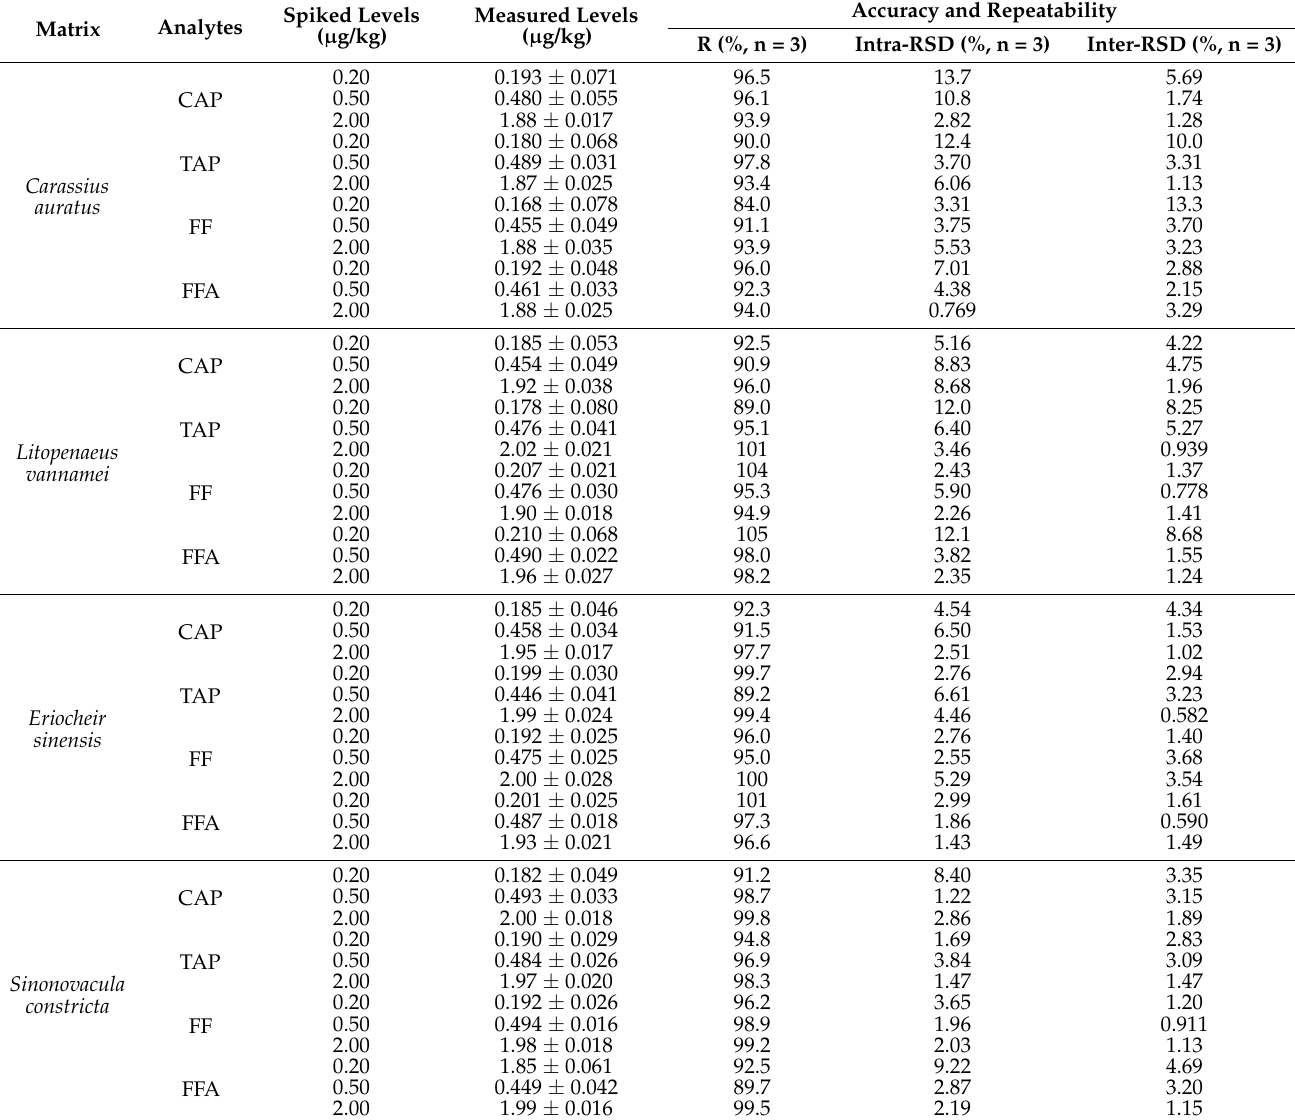
Table 3. The recoveries and RSDs of CAP, TAP, FF, and FFA by the spiked